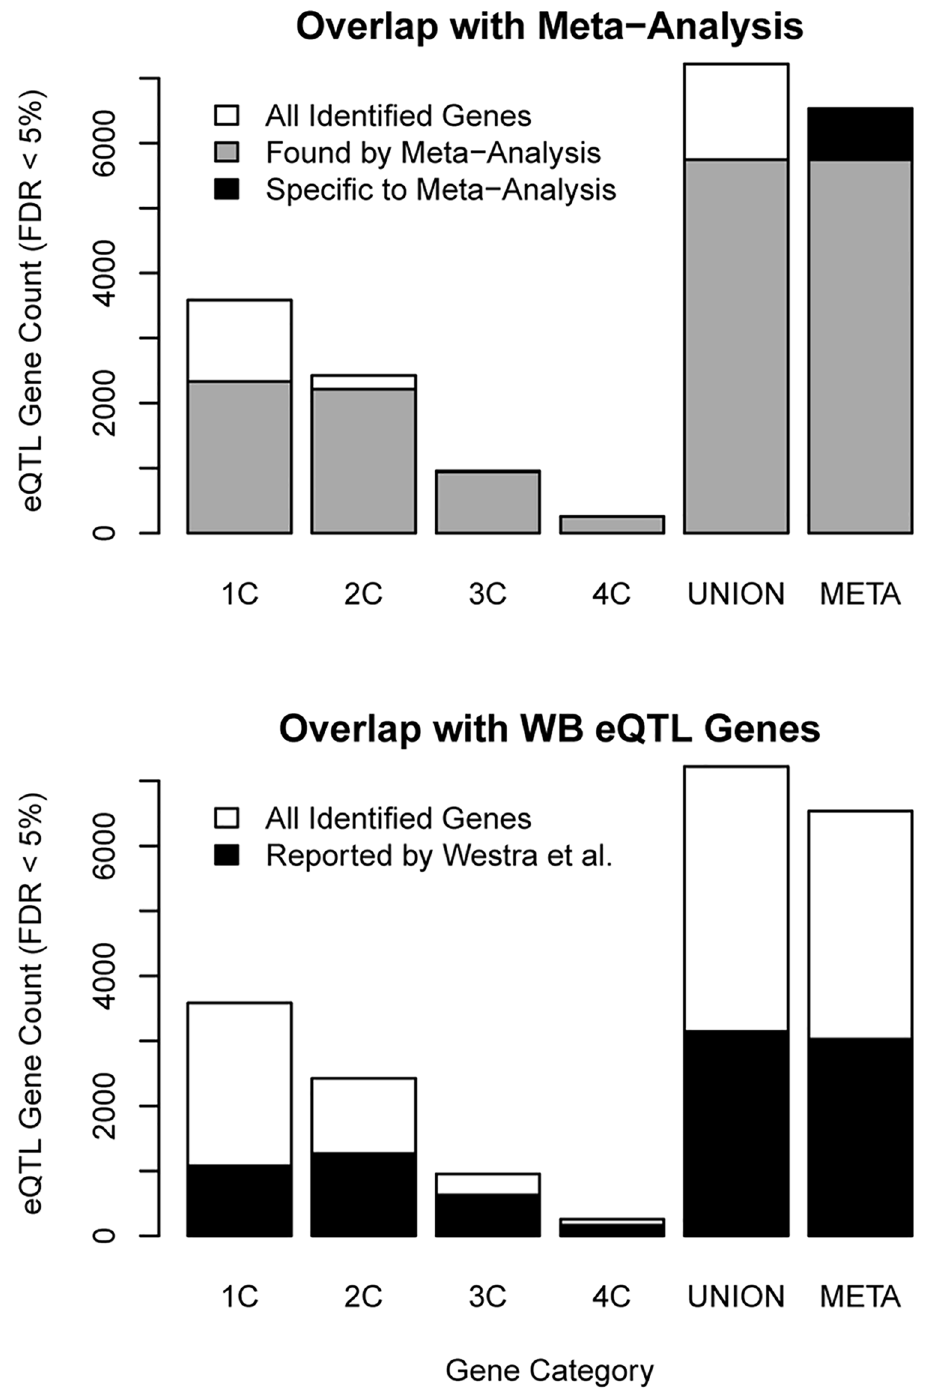
Fig 2. Relationships of eQTL meta-analysis gene yields with representation in individual cohorts and a previous study. Counts of all significant eQTL genes (meta-analysis FDR < 5%, Table 1 ) identified per source category are shown with white bars. The first four categories ( “ 1C ” through “ 4C ” ) represent the number of individual cohorts in which a gene was identified. The fifth category ( “ UNION ” ) is the union of the genes from the preceding four categories. The sixth category ( “ META ” ) is the set of genes identified in the meta-analysis. Top panel : For comparison, the counts of genes in each category also found by the meta- analysis are shown with overlapping gray bars. Among genes found in the meta-analysis, the count of genes not identified in any of the individual cohorts is shown with a black bar. Bottom panel : The counts of genes found in an eQTL study in WB by Westra et al . [13] are shown with black